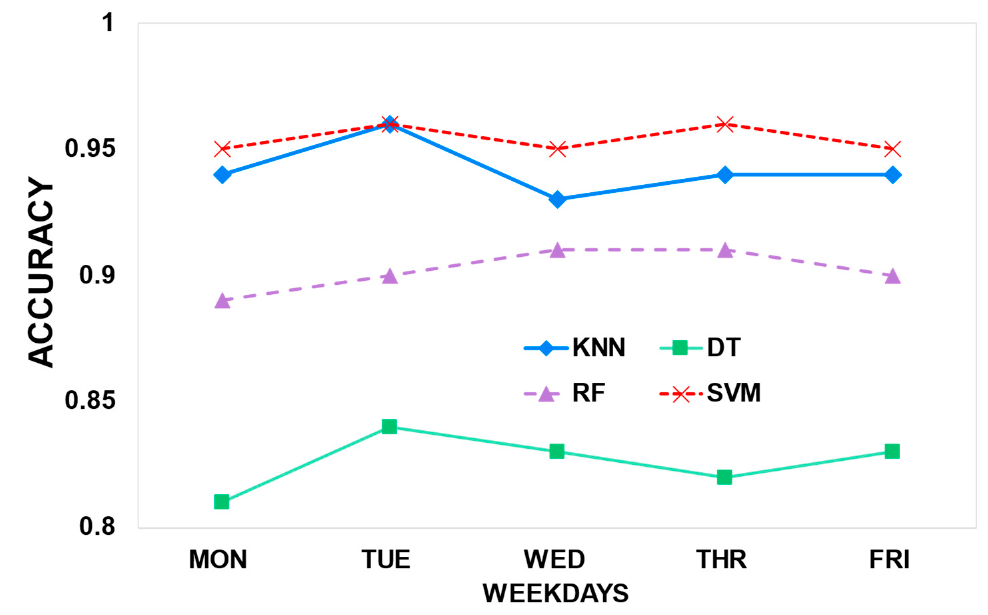
Figure 5. Classification accuracy for UE grouping.